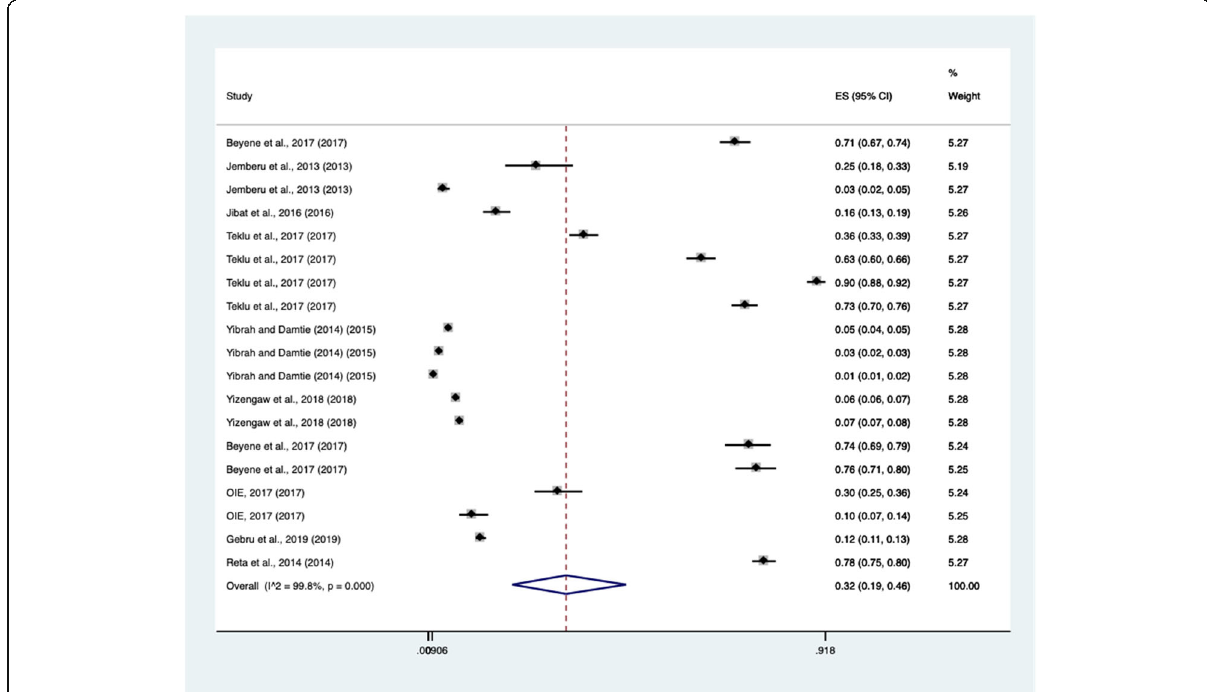
Fig. 2 Forest plot for the pooled prevalence of rabies in Ethiopia from 2010 to